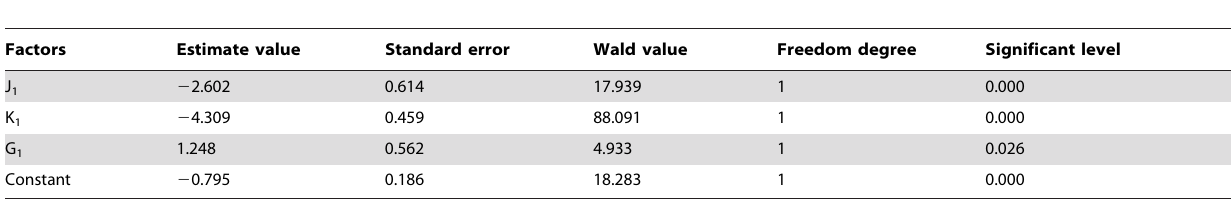
Table 5. Results of logistic regression analyses of risk factors associated with Brucella contamination of raw milk.